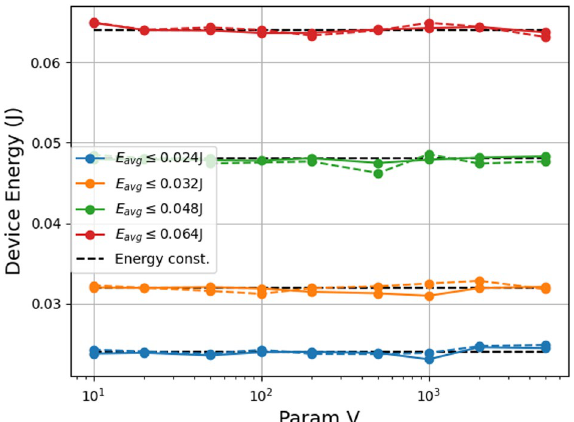
Fig. 11 UE’s energy expenditure vs parameter V . Deep-CE (solid) vs down-sampling (dashed). This figure compares energy expenditure of the UE as a function of the trade-off parameter V considering the deep-CE and the down-sampling compression strategy